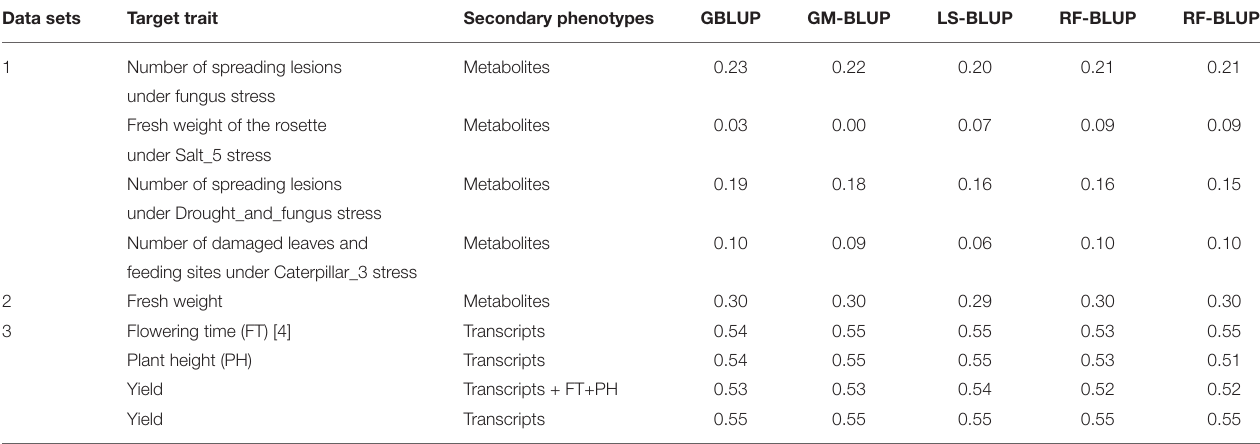
TABLE 1 | Prediction accuracy in scenario 1, for various target and secondary traits in Maize and Arabidopsis. Data sets